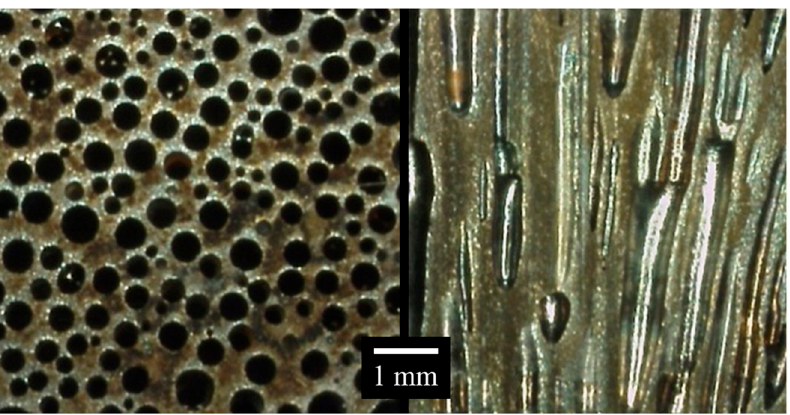
Figure 1. Transversal and longitudinal cross-sections of lotus-type porous iron with 44% porosity [12].